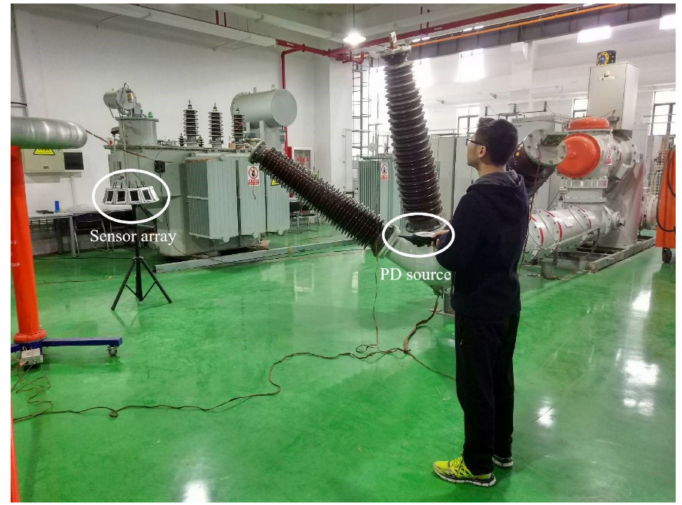
Figure 8. Sensor array in the high voltage (HV) laboratory.